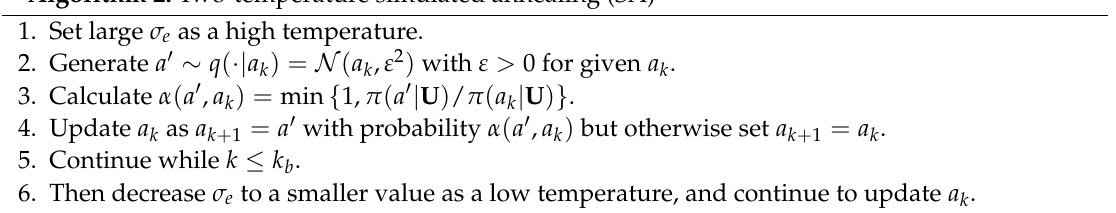
Algorithm 2: Two-temperature simulated annealing